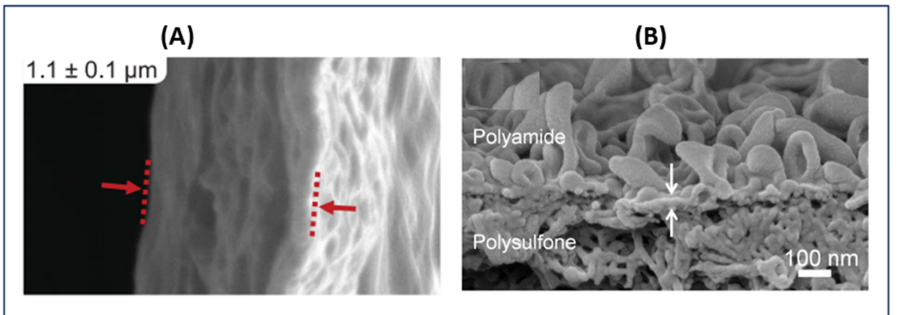
Figure 5. SEM images of polyamide TFC membranes with a polyamide layer: ( A ) printed [7]. Reproduced from Yanar, N.; Kallem, P.; Son, M.; Park, H.; Kang, S.; Choi, H. A New Era of Water Treatment Technologies: 3D Printing for Membranes, Journal of Industrial and Engineering Chemistry; published by Elsevier, 2020 and ( B ) conventional [47]. Reproduced with permission from Perera, D.H.N.; Song, Q.; Qiblawey, H.; Sivaniah, E. Regulating the Aqueous Phase Monomer Balance for Flux Improvement in Polyamide Thin Film Composite Membranes, Journal of Membrane Science; published by Elsevier, 2015.